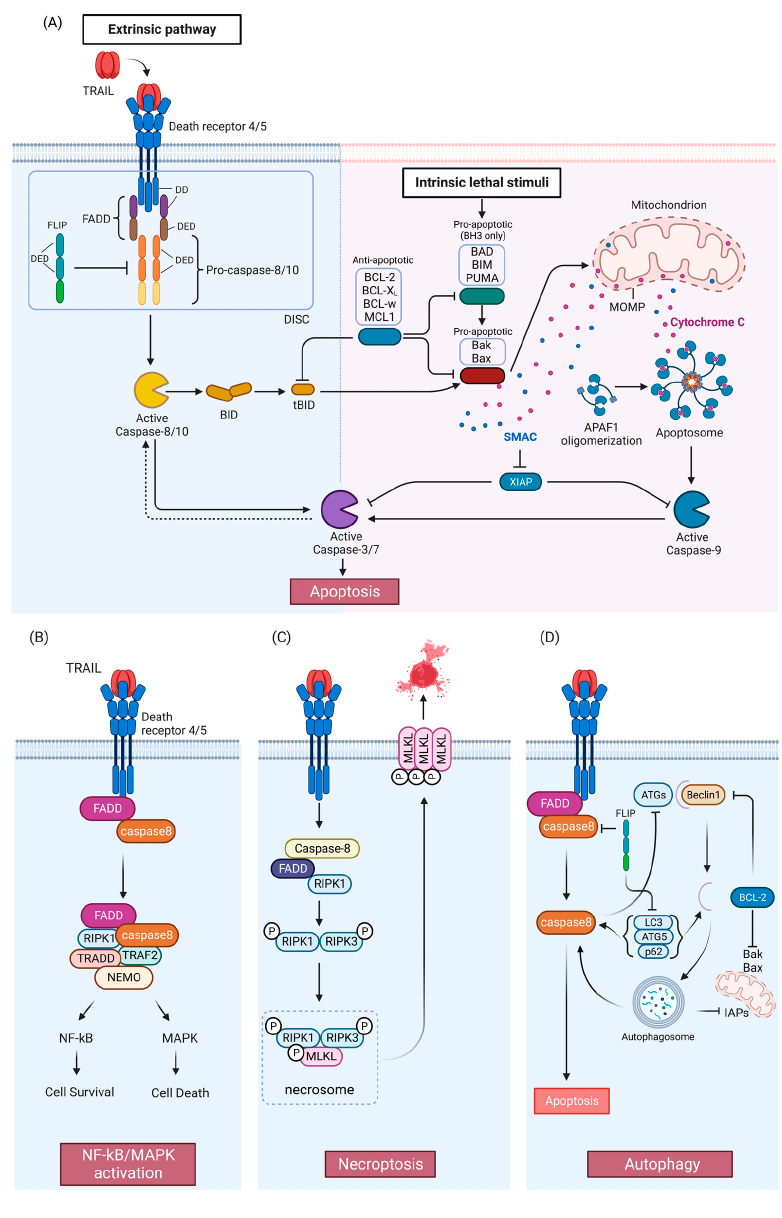
Figure 1. TRAIL signaling pathway. ( A ) Apoptosis pathway. Activation of DR4 and DR5 by TRAIL induces the extrinsic apoptosis pathway (left). The intrinsic pathway (right) is activated by a variety